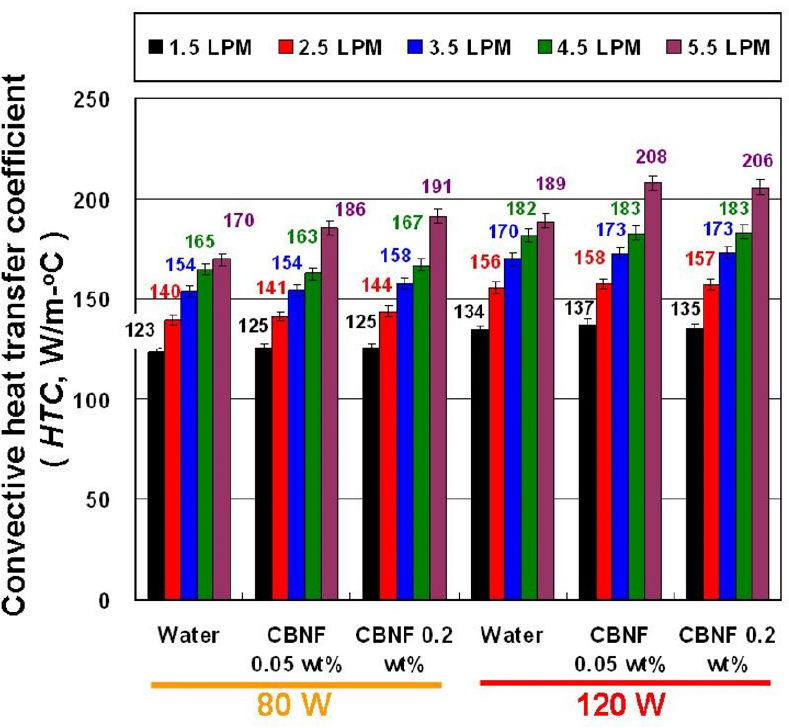
Figure 9. The HTC of test samples for THE at various experimental parameters.